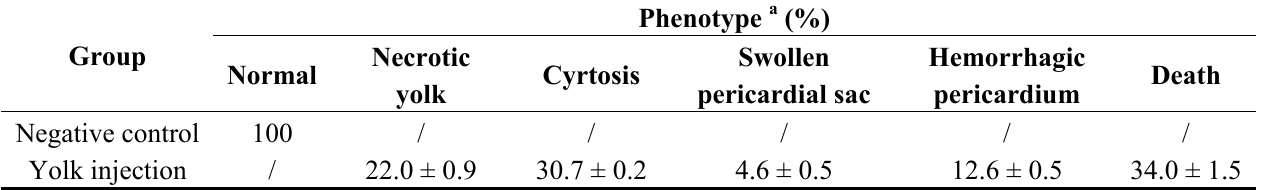
Table 1. Larval phenotype